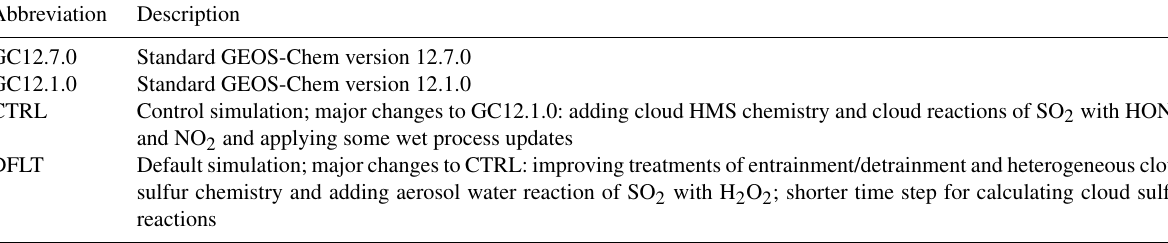
Table 4. Description of model